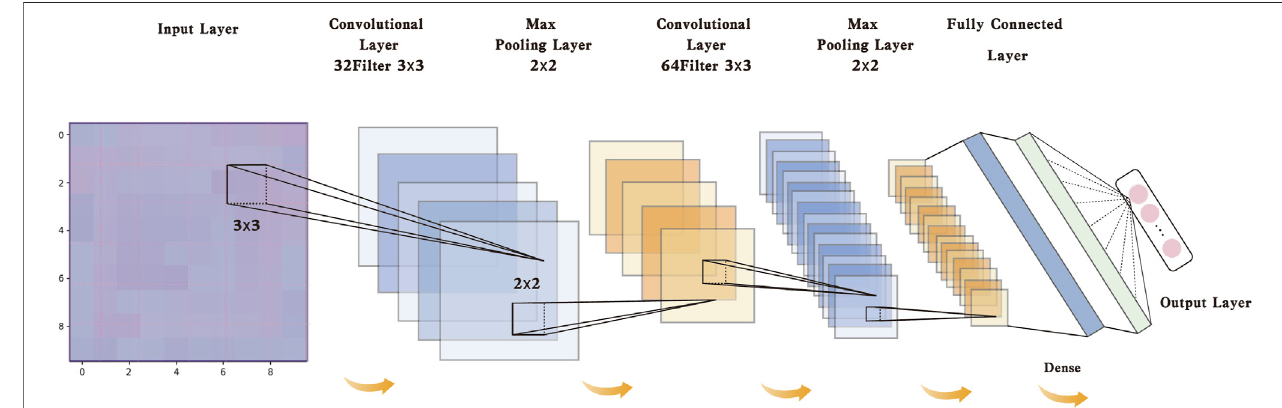
FIGURE 4 | Convolutional neural network